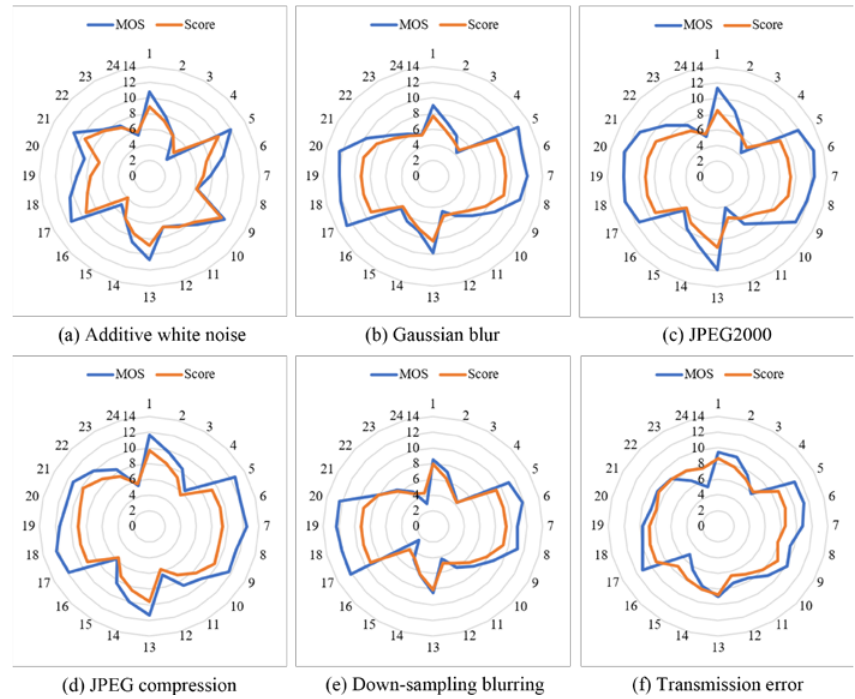
Figure 7. Radar plots of the MOS values and the predicted scores on the MCL-3D test set: ( a ) test result with additive white noise; ( b ) test result with Gaussian blur; ( c ) test result with JPEG2000; ( d ) test result with JPEG compression; ( e ) test result with downsampling blurring; ( f ) test result with transmission error.